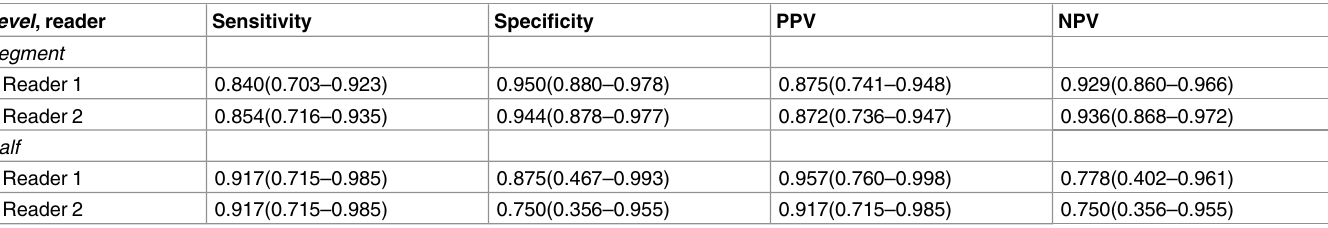
Table 4. Diagnostic accuracy(95%CI) of FSD-MRA, relative to CE-MRA, for detection of clinically significant ( (cid:21)